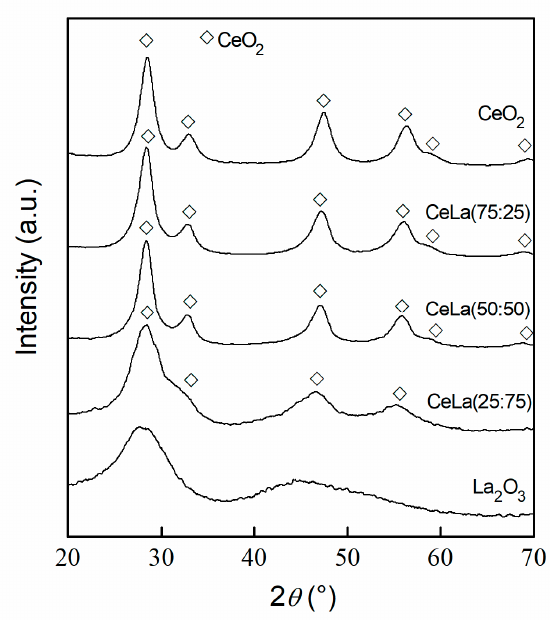
Figure 1. XRD patterns of the prepared oxide catalysts. The nitrogen adsorption ‐ desorption isotherms of all the samples (Figure 2) can be classified as type IVa [22] and exhibit hysteresis loops at a relative pressure >0.4, which suggests the presence of mesopores in a limited size range. With the increase in the lanthanum content, the surface areas ( S BET ) strongly decrease from 189 to 74 m 2 g − 1 , whereas pore volumes ( V p ) are in the range of 0.31–0.37 cm 3 g − 1 . As can be observed, the S BET values of the present samples are definitely high in comparison with those reported in the literature for CeO 2 ‐ La 2 O 3 mixed oxides prepared by coprecipitation (41–62 m 2 g − 1 ) [14], highlighting the effectiveness of the soft template method for the synthesis of materials with high surface areas. The pore size distribution curves (PSD, inset in Figure 2) indicate a monomodal distribution, where the maximum ( d p,max ) shifts to larger values as the lanthanum content increases (Table 1).